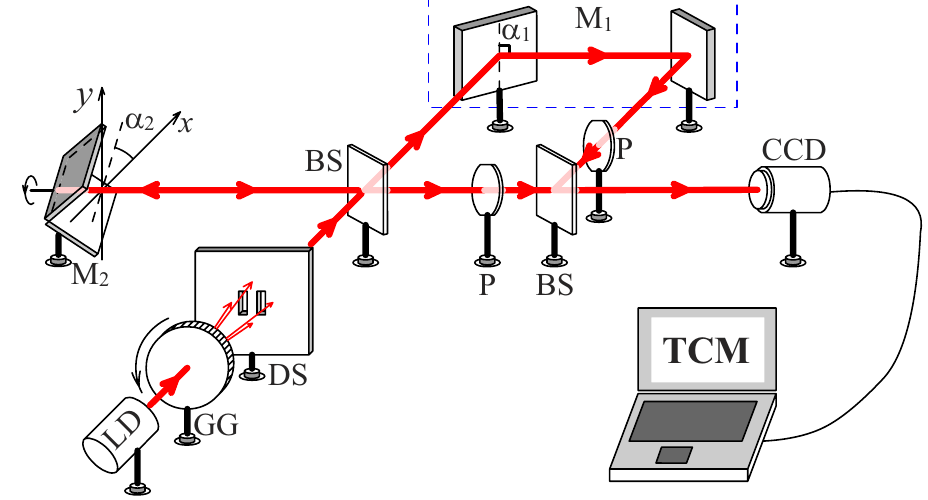
Figure 1. Experimental setup of wavefront rotation interferometer. LD is a laser diode of wavelength 650 nm. GG is a rotating ground glass disk. DS is composed of double slits. BS is the beam splitter. M 1 and M 2 are two right-angle mirrors, where M 1 is composed of two separate sub-mirrors. P is the polarization plate. The two- photon correlation measurement (TCM) is implemented with a charge coupled device (CCD).